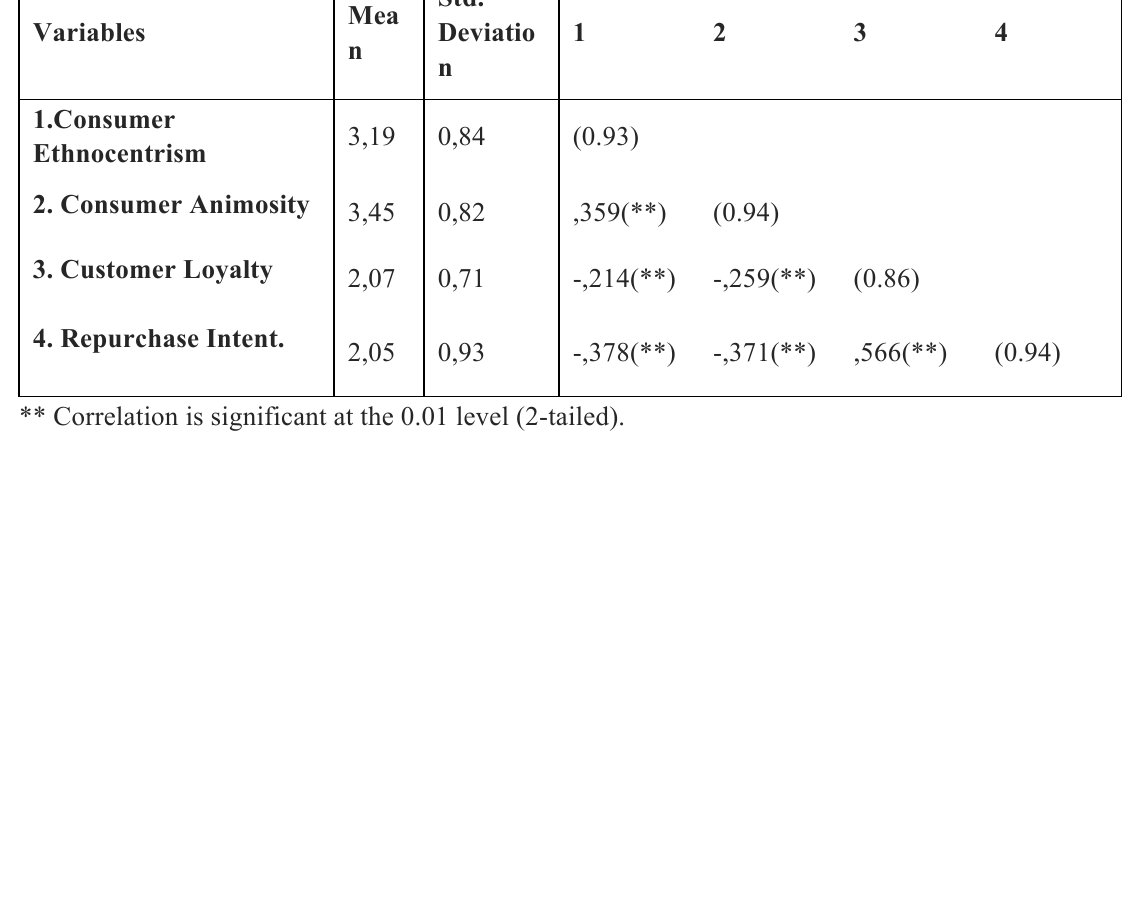
Table 2: Descriptive statistics and intercorrelations among study variables